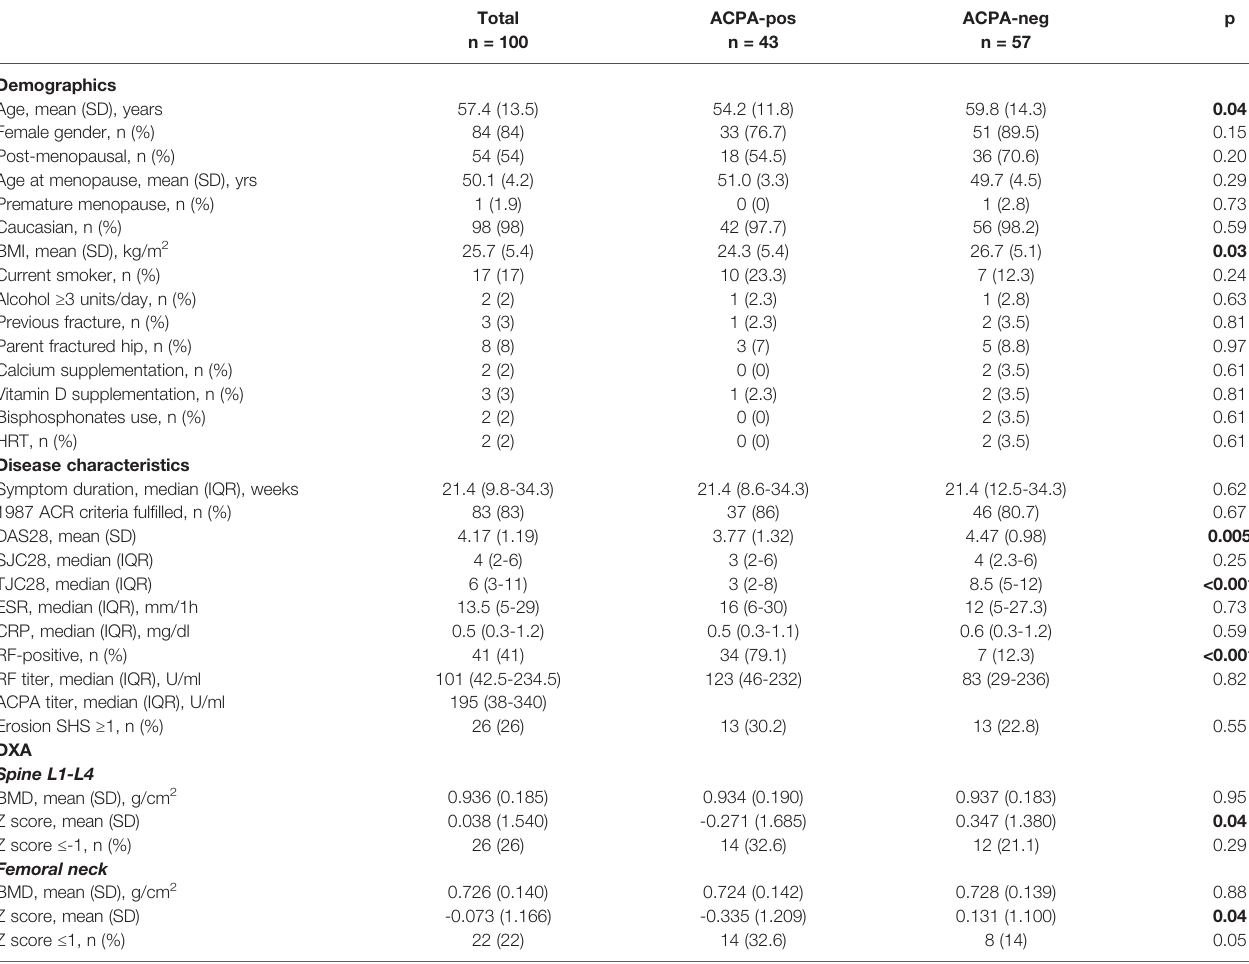
TABLE 1 | Baseline demographic and clinical characteristics of the study